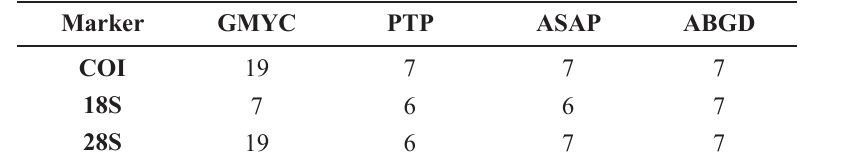
Table 2. Results from species delimitation analyses using GMYC, PTP, ASAP, and ABGD on individual marker datasets showing the number of OTUs delimited. Sequences from Lebertia (s. str.) sp. (outgroup) and L. insignis (the only taxon of Pilolebertia that could be morphologically separated at the start of the project) were excluded.